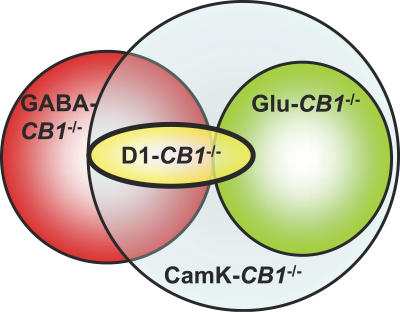
Graphic Representation of the Recombination Patterns of the CB1 Gene in the Different Conditional Mutant LinesCircles represent “domains“ of recombination. Intersection areas represent overlapping between the different recombination patterns. CaMK-CB1
−/− mice (light blue) present the widest recombination of CB1, which is partially overlapping with the one of GABA-CB1
−/− mice (red-blue overlapping, i.e., principal striatal GABAergic neurons). GABA-CB1
−/− mice (red) present a specific deletion of GABAergic neurons, which are specific of this line concerning cortical GABAergic interneurons (non-overlapping red area), but overlap with CaMK-CB1
−/− and D1-CB1
−/− mice in the striatum. Glu-CB1
−/− recombination (green) fully overlap only with CaMK-CB1
−/− (glutamatergic cortical neurons). D1-CB1
−/− mice (yellow) share with GABA-CB1
−/− and CaMK-CB1
−/− the deletion in the majority of striatal neurons and with Glu-CB1
−/− and CaMK-CB1
−/− the deletion in glutamatergic layer VI neocortical neurons.Proportions of overlapping areas are not quantitative and are not representative of cell numbers. Descriptive expression data are collected from previous publications [27,28] and from the present study.